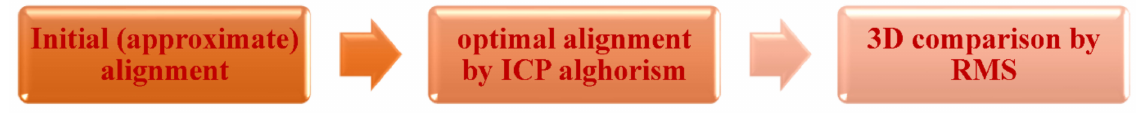
Figure 9. 3D analysis with Geomagic